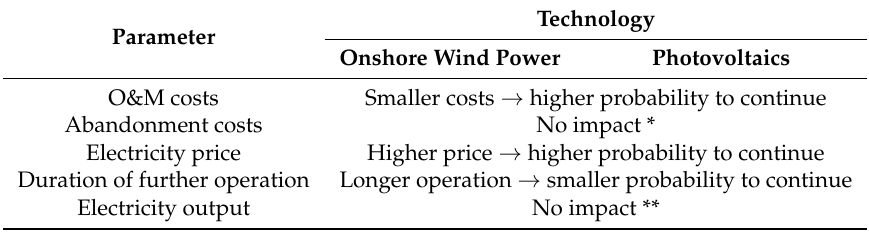
Table 7. Impact of different parameters on the decision to continue